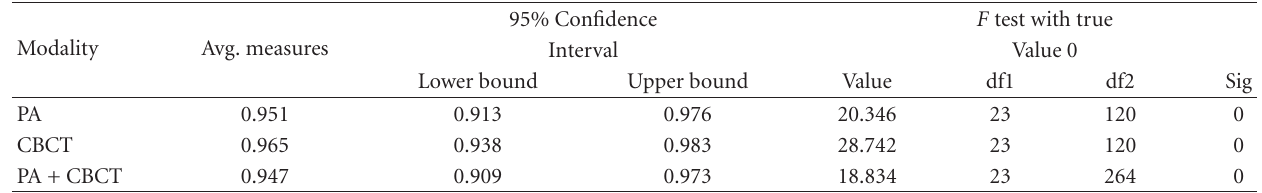
Table 5: Intraclass correlation among observers for PA and CBCT with reference to lesion size.